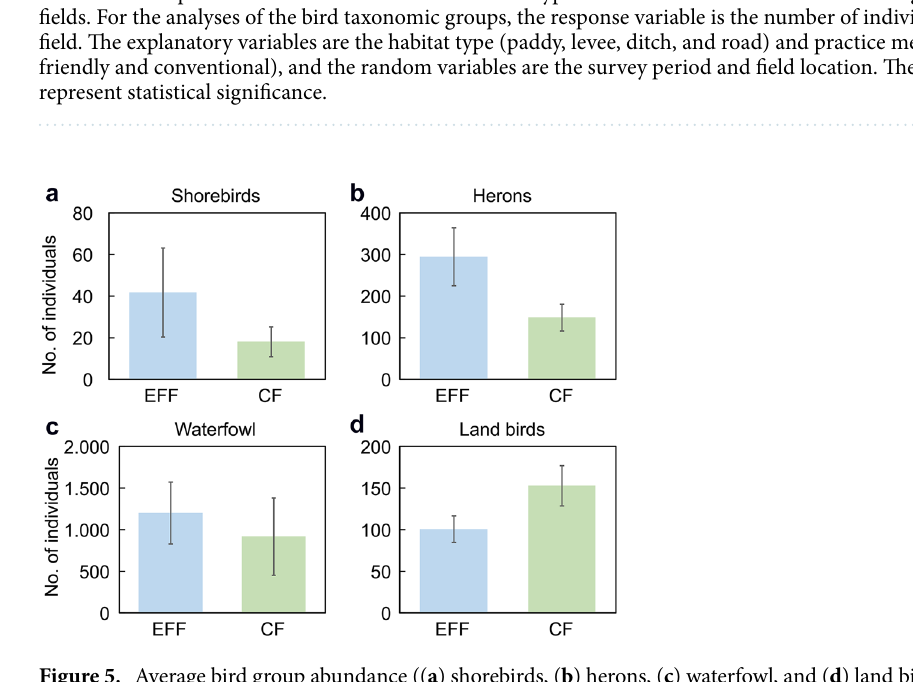
Figure 5. Average bird group abundance (( a ) shorebirds, ( b ) herons, ( c ) waterfowl, and ( d ) land birds) values between eco-friendly fields (EFF) and conventional fields (CF) according to main occurrence period (shorebirds: April–May, and August–September; herons: May–October; waterfowl: October–April; land birds: all seasons). The sample size was 36, which is the number of surveys (once per month for 3 years, from January 2014 to December